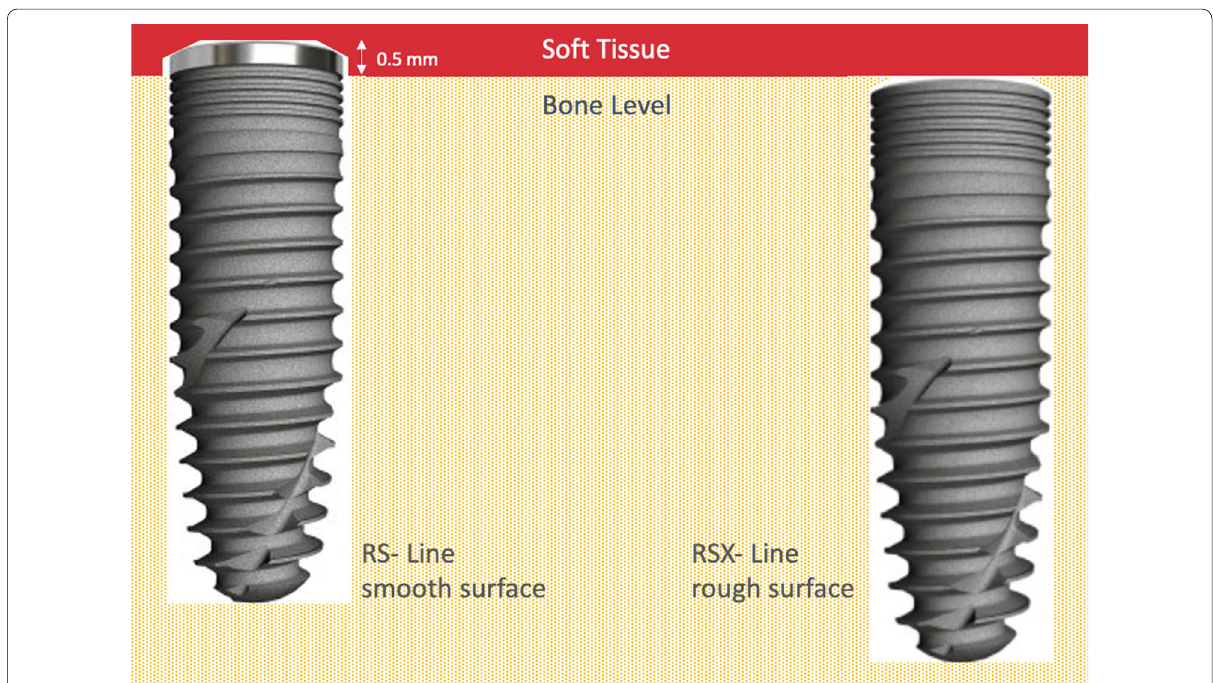
Fig. 2 Implant macro-designs: RS-line implant left (polished shoulder) and RSX-line implant (rough shoulder) right. RSX-line implants were aimed to be completely inserted leveling the alveolar crest. The intended position for the RS-line implants was 0.5 mm supracrestal, thus positioning the polished shoulder in direct contact to the oral soft tissue environment